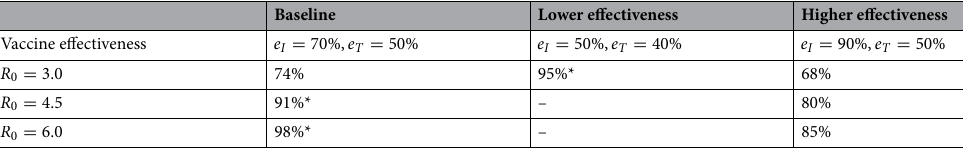
Table 2. Population immunity threshold estimates for each vaccine effectiveness scenario at three different values of R 0 . Estimates assume a structured roll-out, beginning in 65 + year-olds, then 15–64 year-olds, and finally under 15-year olds, with up to 90% of each group vaccinated. Estimates with an asterisk are greater than 90% and assume equal coverage in all age groups.